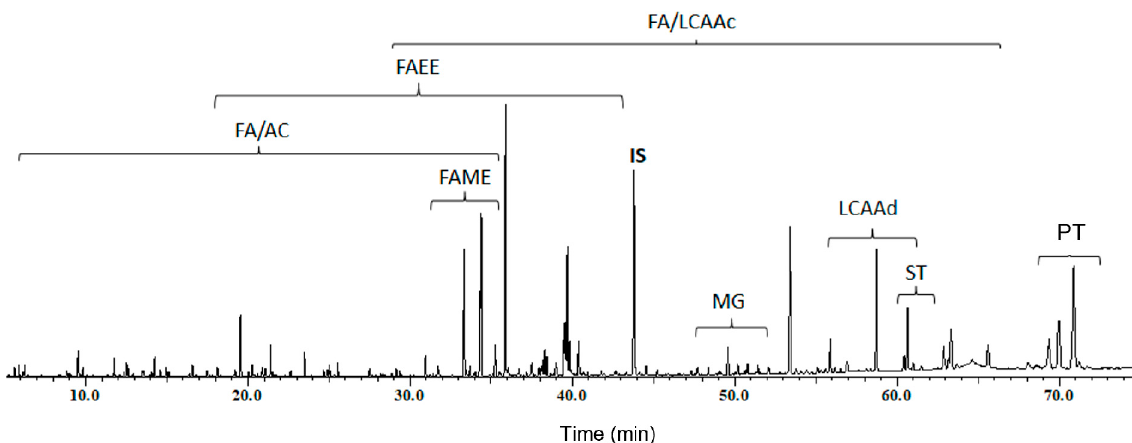
Figure 1. GC − MS chromatogram of the trimethylsilyl-derivatized dichloromethane extract from Z. lotus pulp. Abbreviations: AC, aromatic compounds; IS, internal standard (tetracosane); FA, fatty